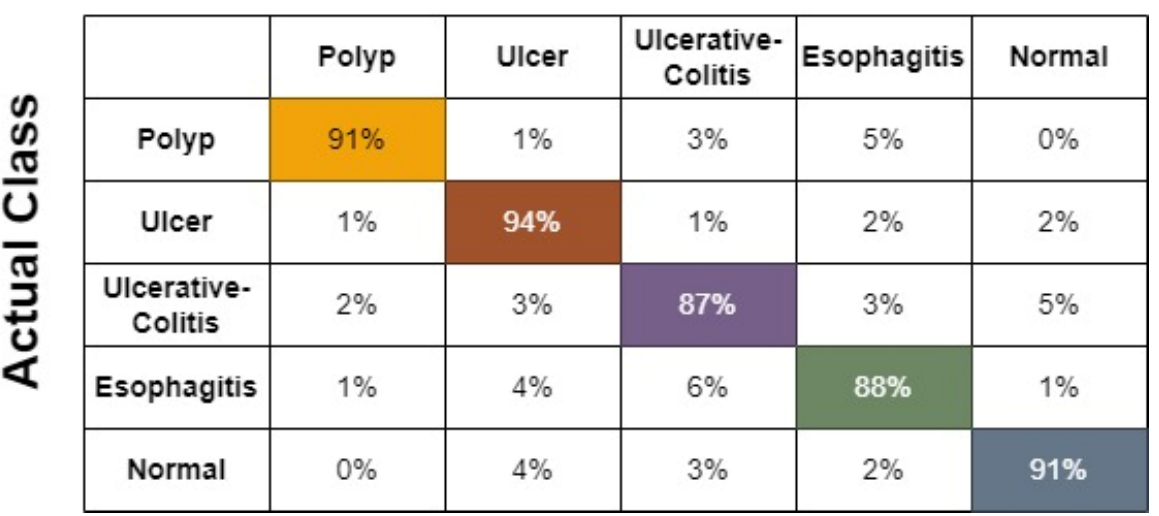
Figure 8. Confusion matrix using softmax classifier for contrast enhanced dataset.